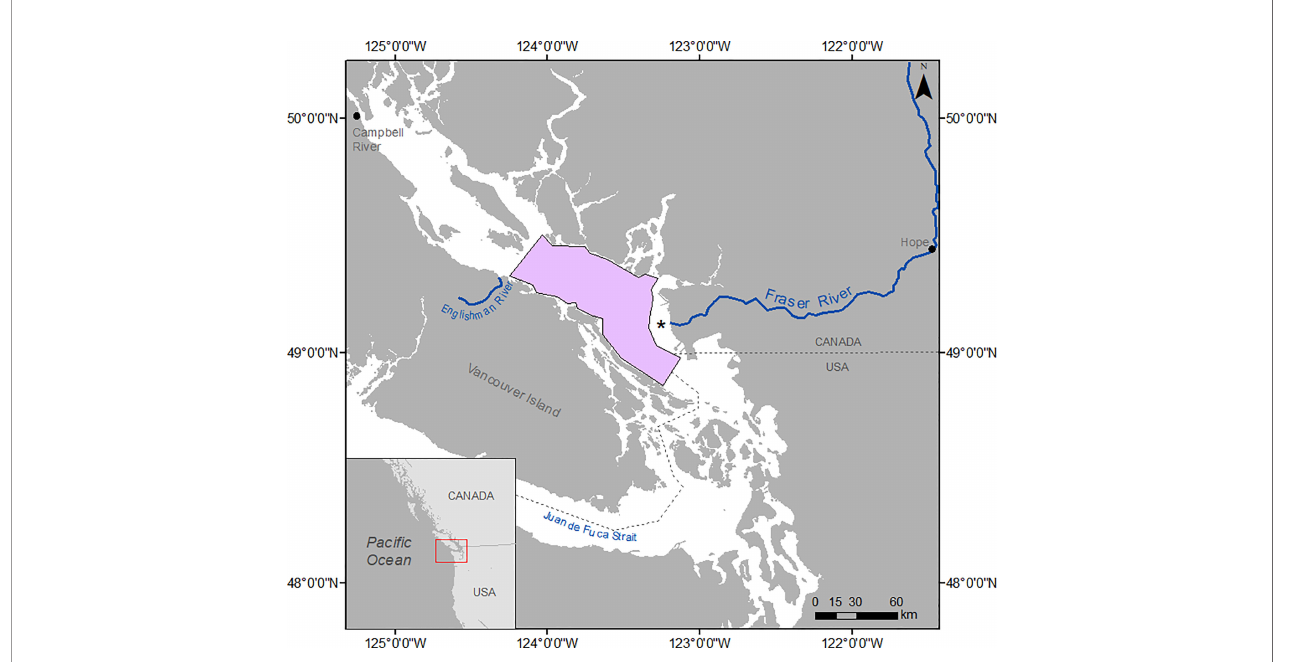
FIGURE 1 | Map showing the Central Strait of Georgia (SoG), BC, Canada, study area (purple shading). Asterisk * indicates the high turbidity region near the mouth of the Fraser River that was masked during satellite